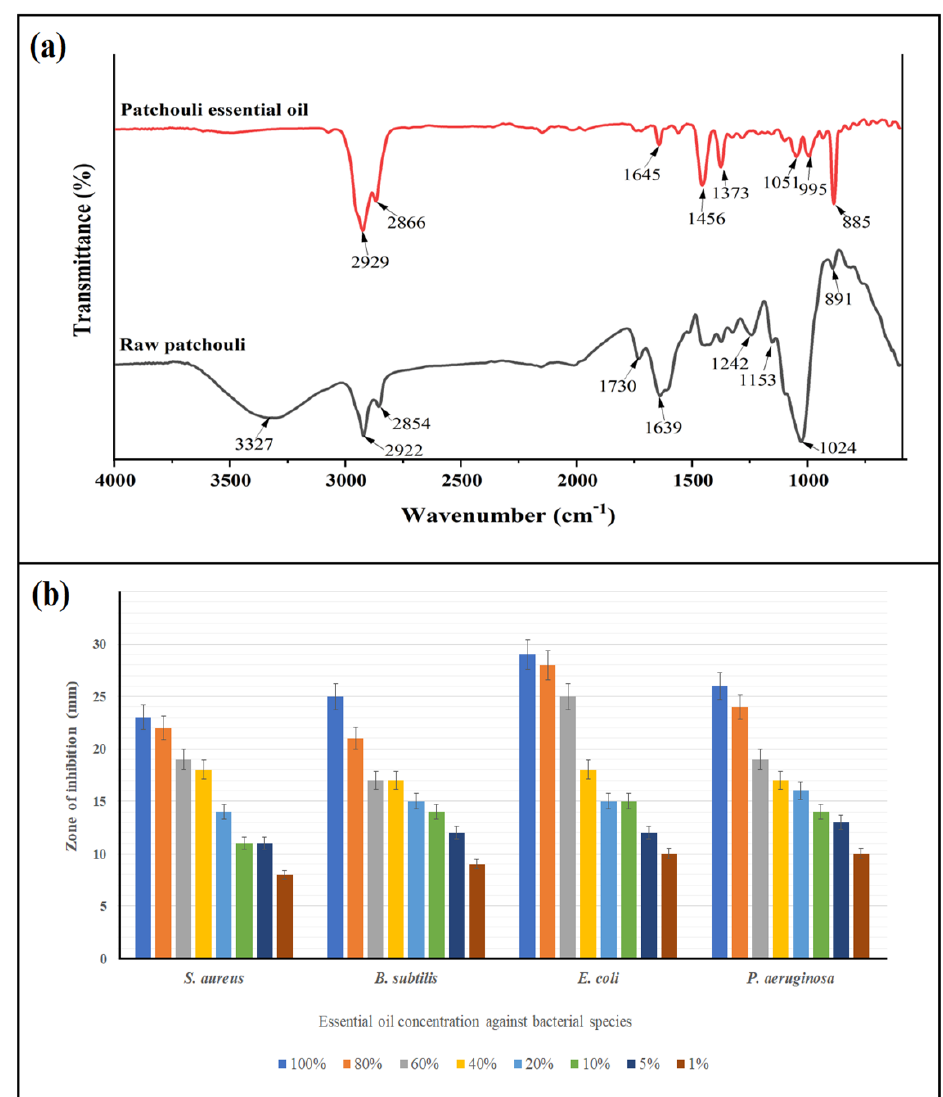
Figure 1. Characterization of patchouli essential oil; ( a ) FT-IR spectra and ( b ) antibacterial activity against the selected microorganisms.